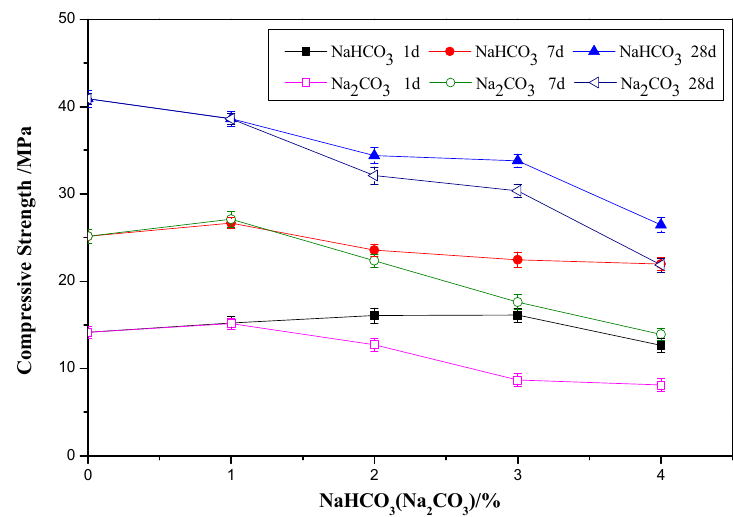
Figure 2. Effects of NaHCO 3 and Na 2 CO 3 on the compressive strength of OPC paste.